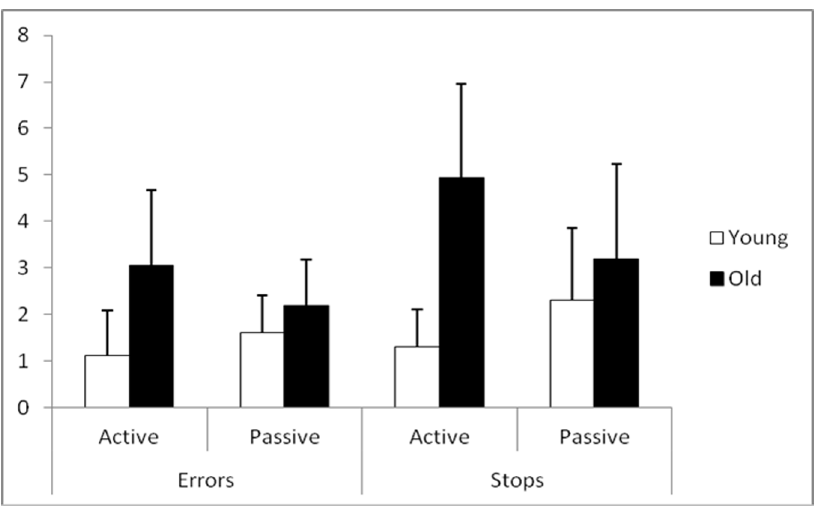
Figure 2. Wayfinding performances as a function of age and the navigation condition. Mean and Standard deviation for the number of Wayfinding errors and stops, according to the active and passive learning conditions and age; ANOVA (Group x Exploration) results.